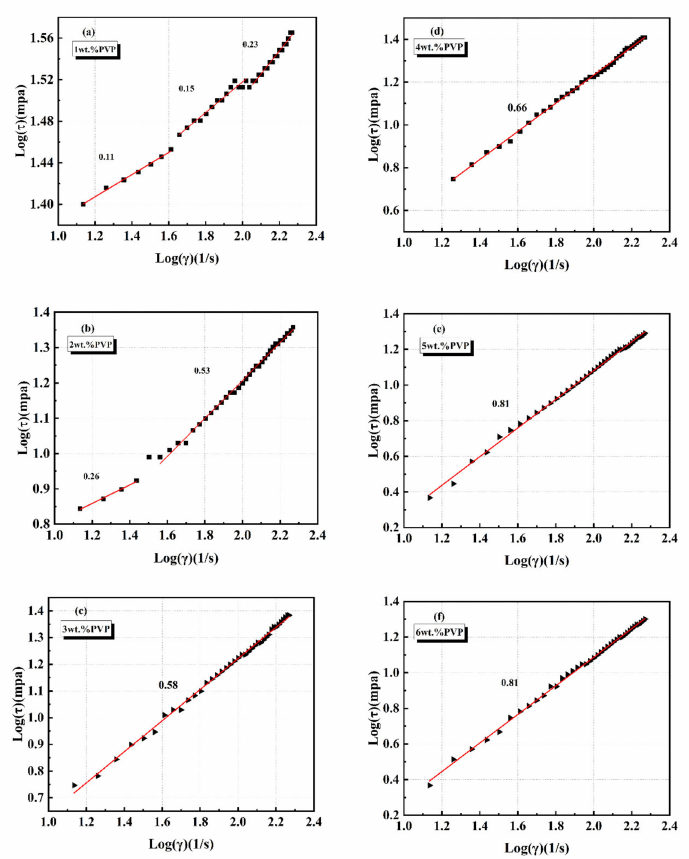
Figure 5. Double logarithmic power law plot at ( a )1wt.%, ( b ) 2wt.%, ( c ) 3wt.%, ( d ) 4wt.%, ( e ) 5wt.%, ( f ) 6wt.% of dispersant for PVP-stabilized suspensions (at 20 vol.%). The viscosity data are presented in the inset of main